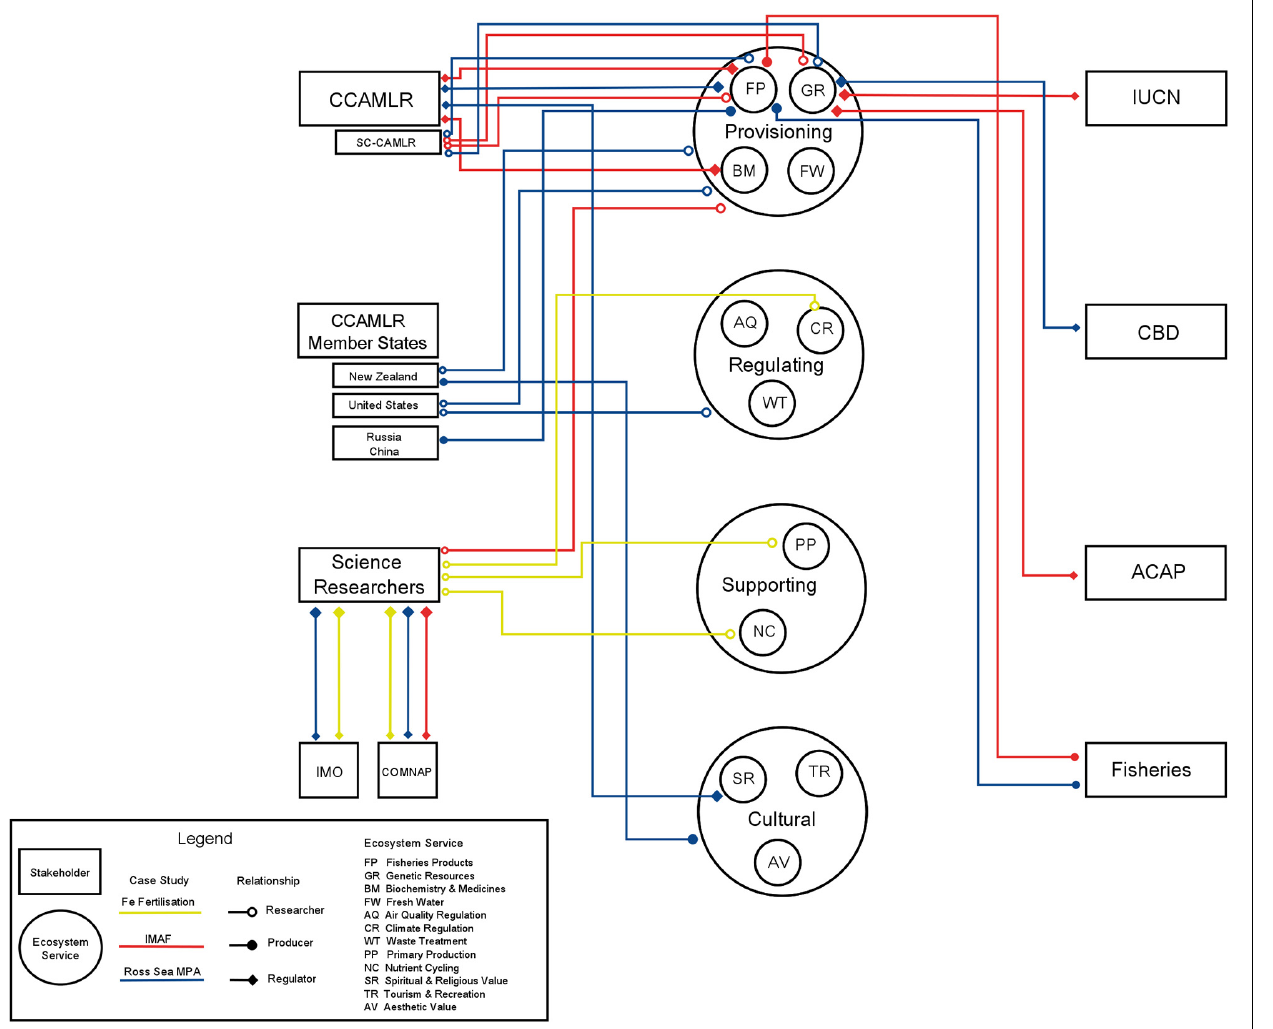
FIGURE 4 | Relationships between key stakeholders and ecosystem services in three Southern Ocean ecosystem management case studies. Note that IMO and COMNAP regulate science researchers for the listed case studies (as IMO and COMNAP do not regulate the ecosystem services